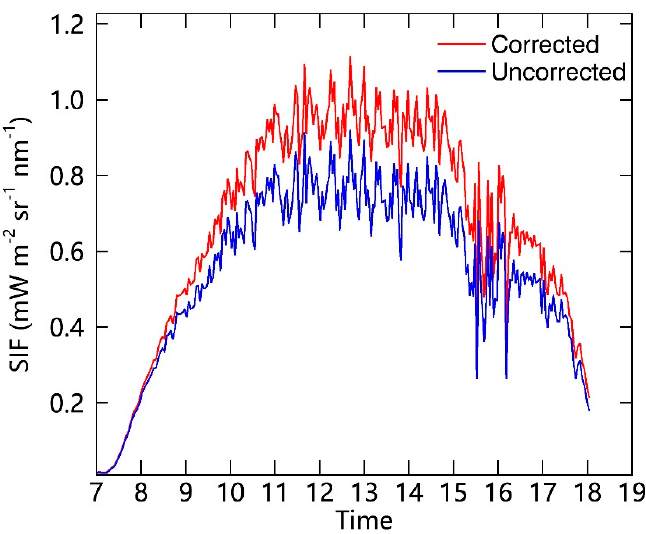
Figure 6. The diurnal variations in SIF results at the O 2 –A band before/after atmospheric correction as measured on 7 September 2017 at the DM site (corrected: red; uncorrected: blue).